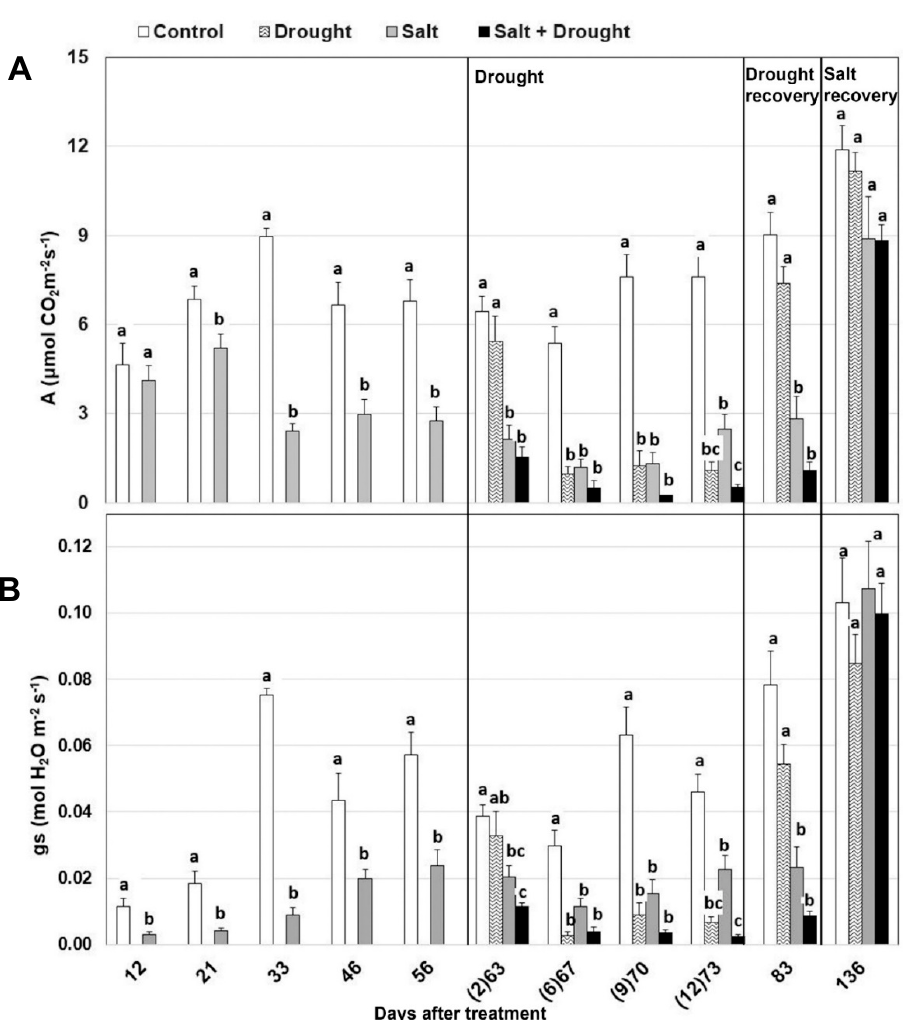
Figure 3. Effect of drought, salt, and the combination of both stresses on ( A ) photosynthesis and ( B ) stomatal conductance. The days after drought treatment are reported in brackets. Values per treatments are mean ± SE ( n = 10). Data characterized by the same letter do not differ significantly ( p < 0.05, Tukey’s HSD test).